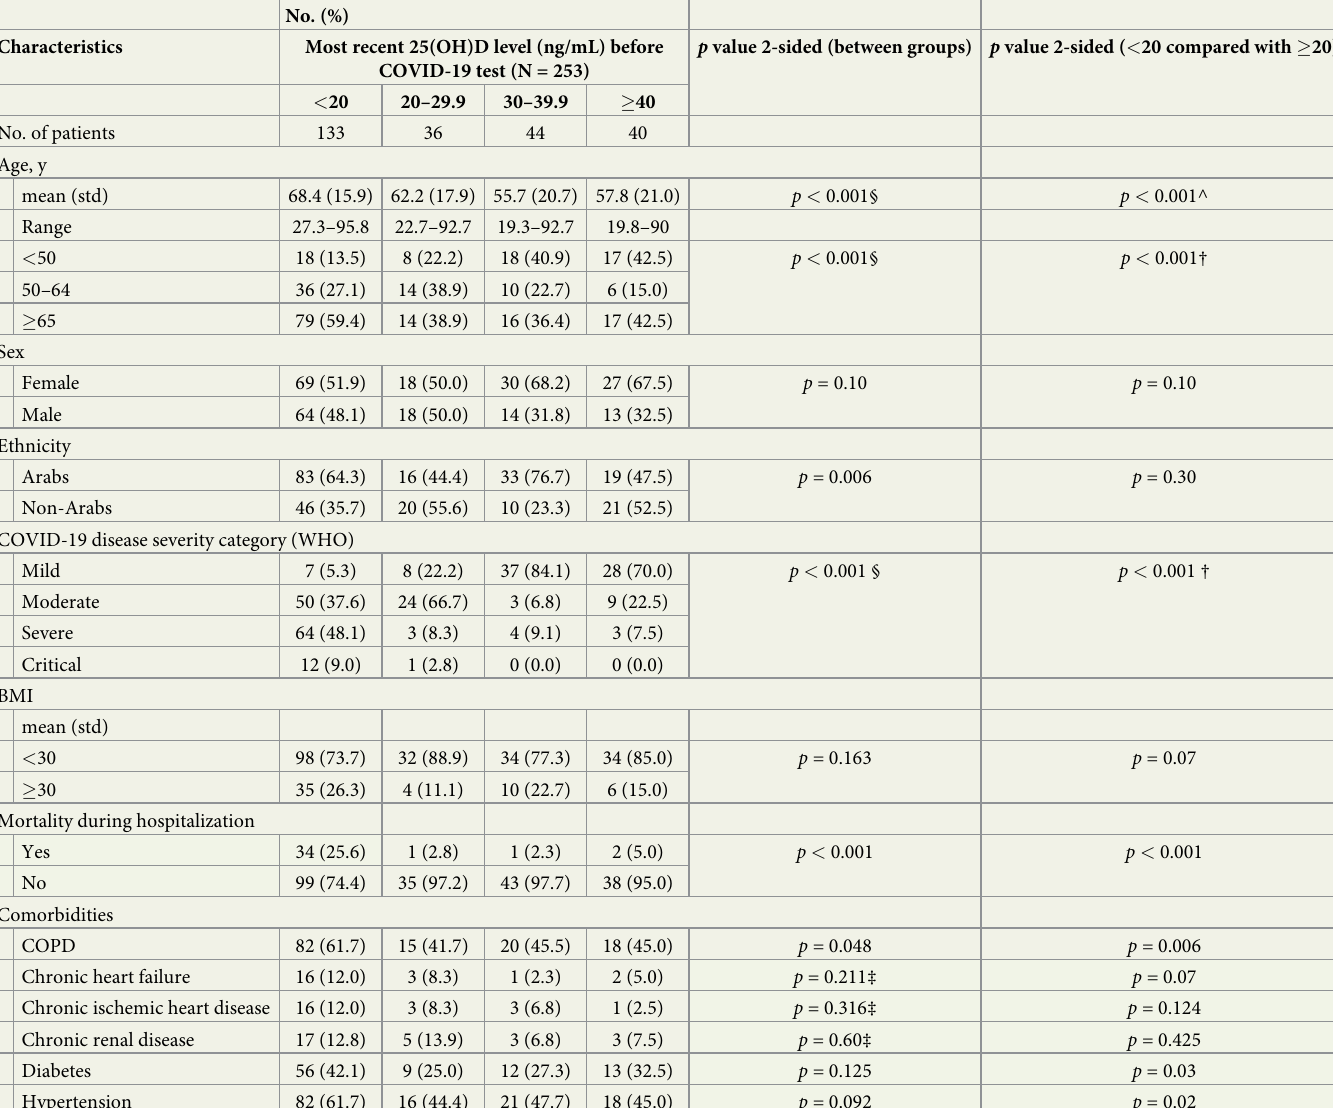
Table 1. Characteristics of hospitalized COVID-19 patients stratified by pre-infection 25(OH)D level measured 14 to 730 days before positive COVID-19 test. No. (%)